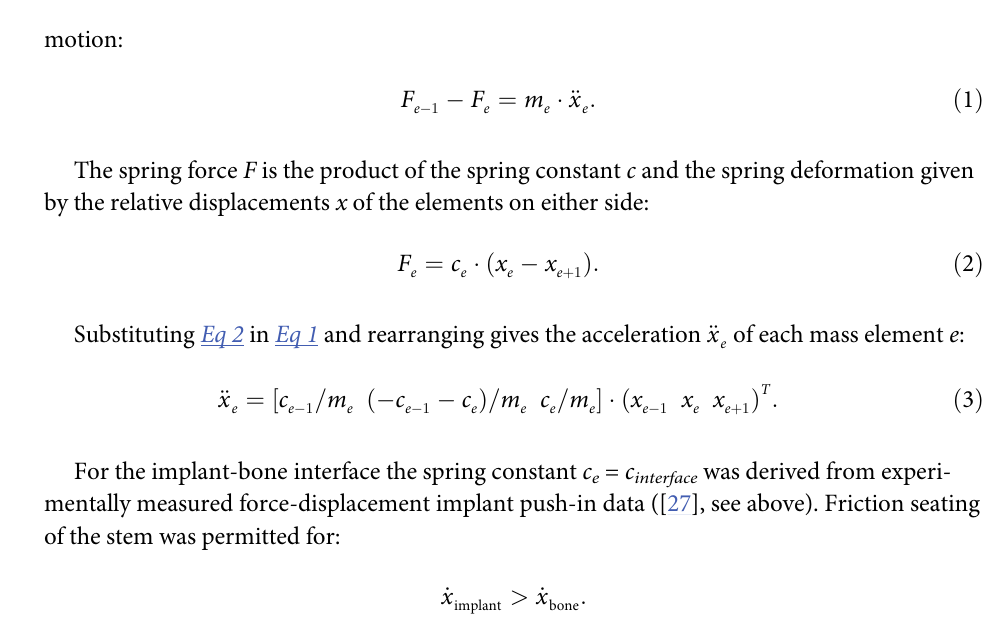
Fig 1. Axisymmetric model of a hammer/tip/introducer/implant/bone/soft-tissues/operating-table with a schematic of the discretised elements (masses, springs, damper) and the forces F acting on a mass element e due to the deformations x of the springs (or damper) on either side. Implant seating friction was simulated by a one-way ratchet between implant and bone, in parallel with a stiffness element (black spring). Nominal values are given, which are listed with details in Fig 2 .